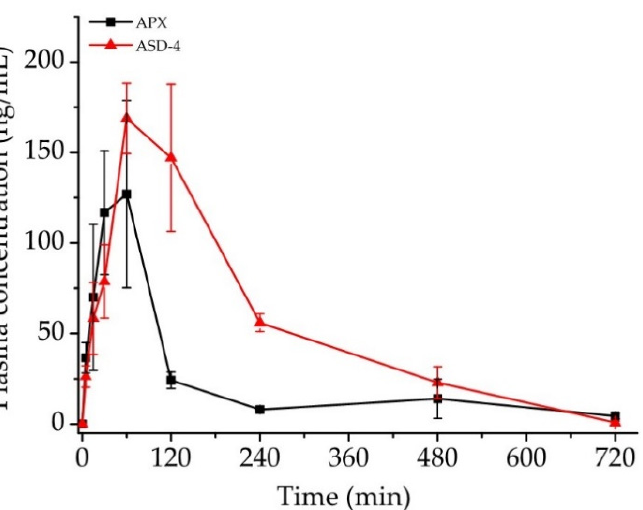
Figure 7. Pharmacokinetic profile of oral APX and ASD-4 in rats (mean ± S.D, n = 3). The dose was equivalent to 2 mg/kg of apixaban. Table 6. Pharmacokinetic parameters of oral APX and ASD-4 in rats (mean ± S.D, n = 3).